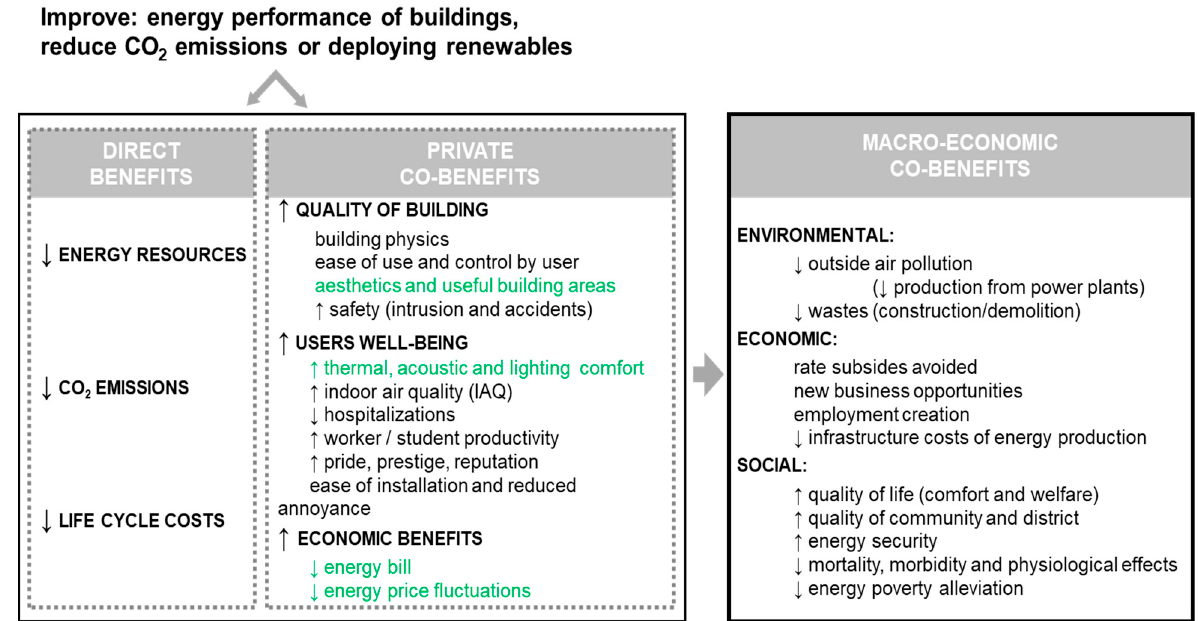
Figure 1. Energy performance’s benefits and co-benefits classification. Source: Self elaboration from the study “Impact of co-benefits on the assessment of energy related building renovation with a nearly-zero energy target” [15].